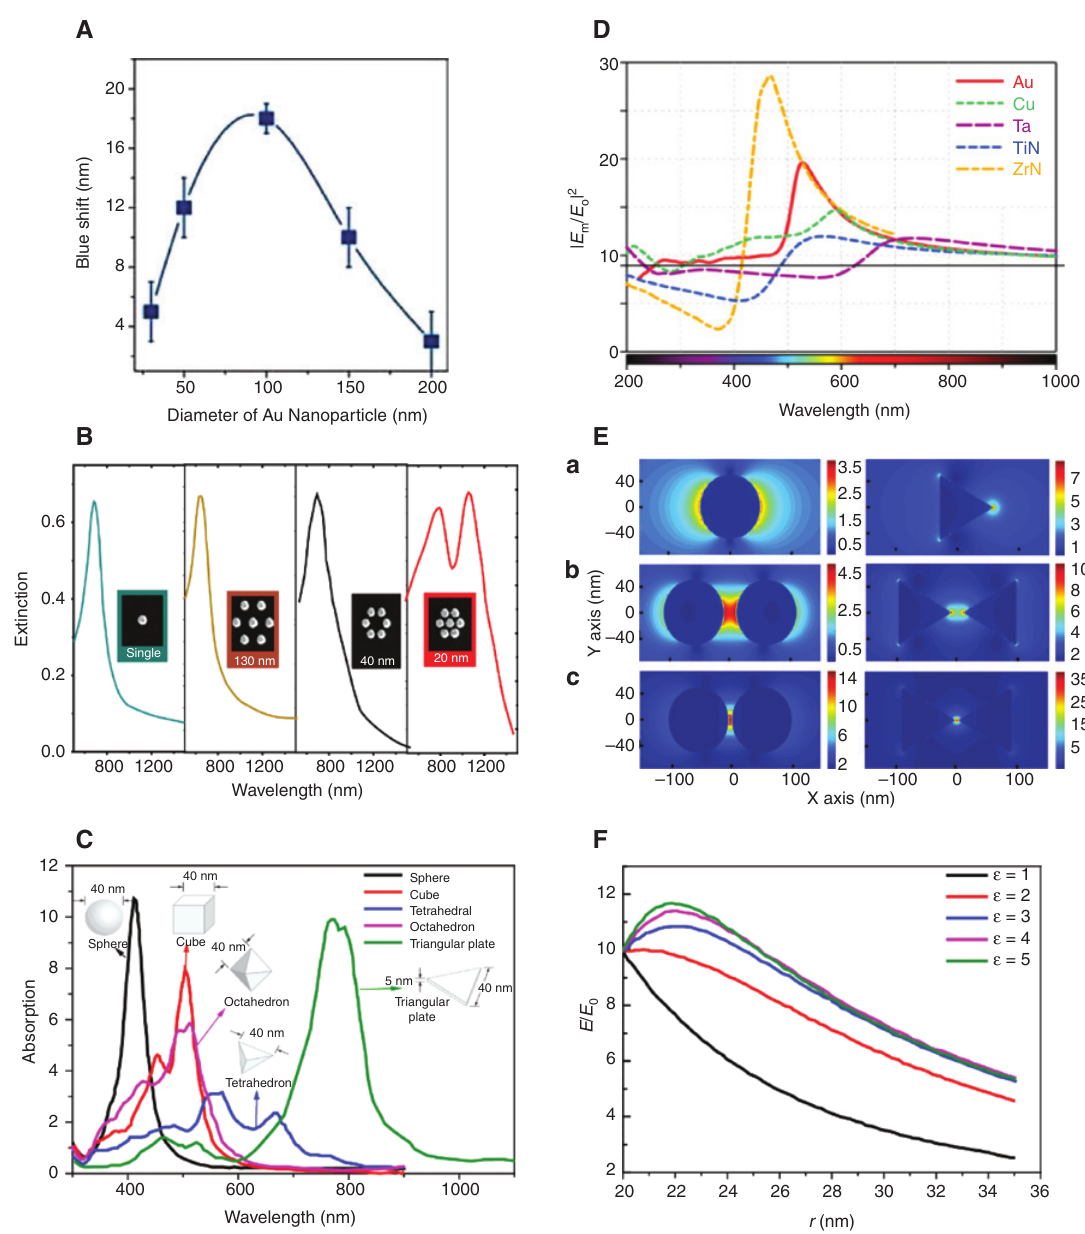
Figure 2: Absorption bandwidth and localized electromagnetic field